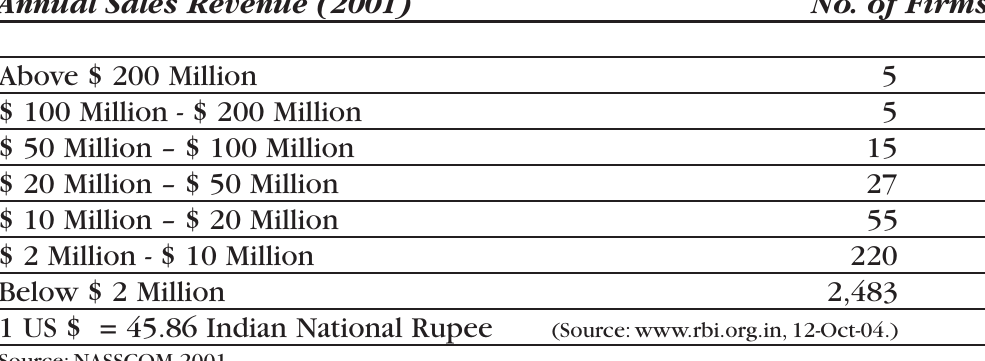
Table 1. Industry Structure of Indian IT